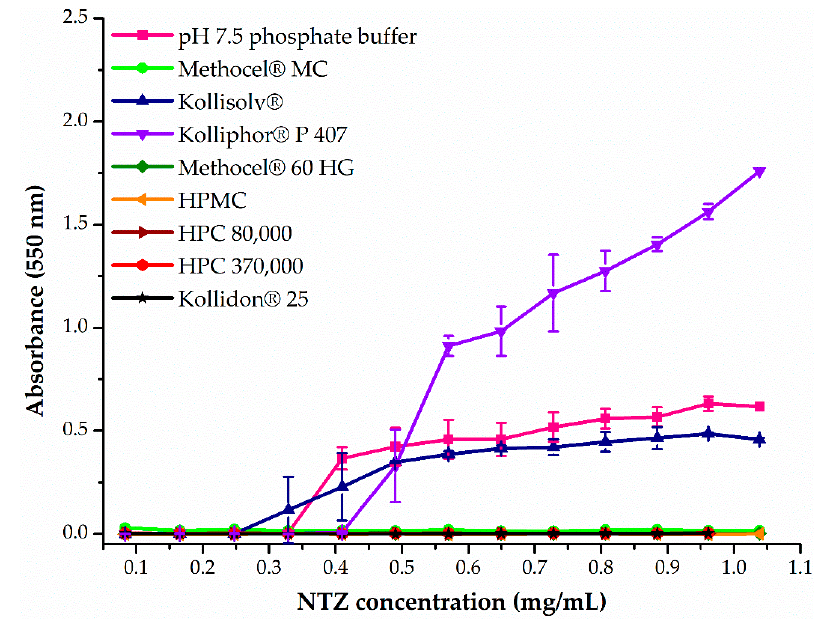
Figure 1. Inhibitory effect of pre-dissolved polymers (0.5% w / v ) on NTZ precipitation in pH 7.5 PBS. ( n = 3 ± SD).